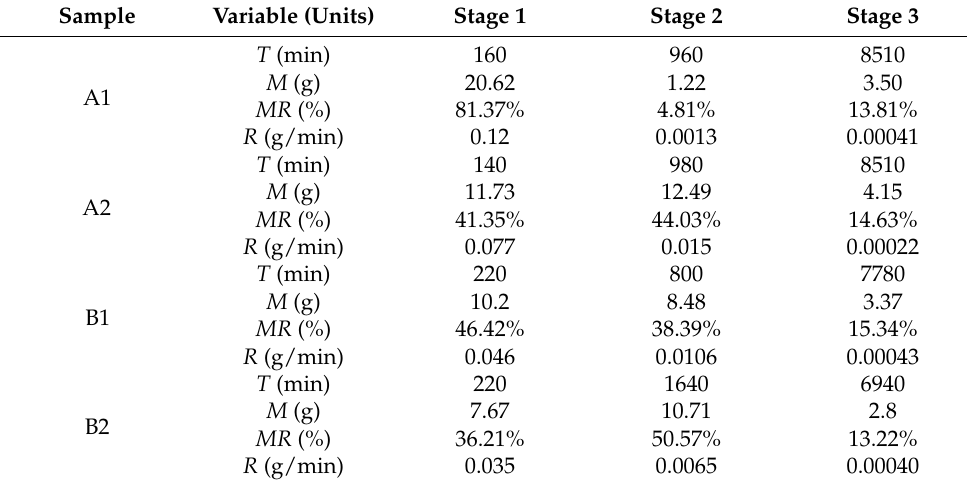
Table 3. Water-absorption time and mass of samples at each